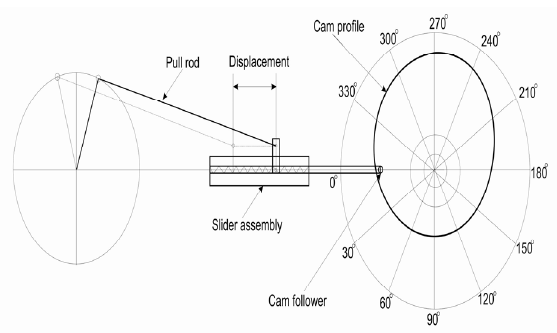
Figure 7. Cam profile and displacement of slider assembly